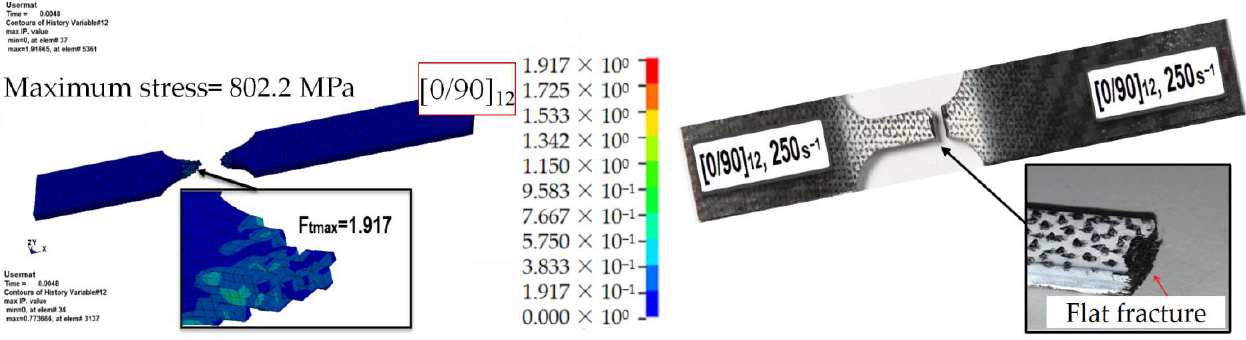
Figure 7. Fiber tensile failure factor contour map and failure mode of the [0/90] 12 specimen tested at a strain rate of 250 s −1 when d = 0.15 mm.